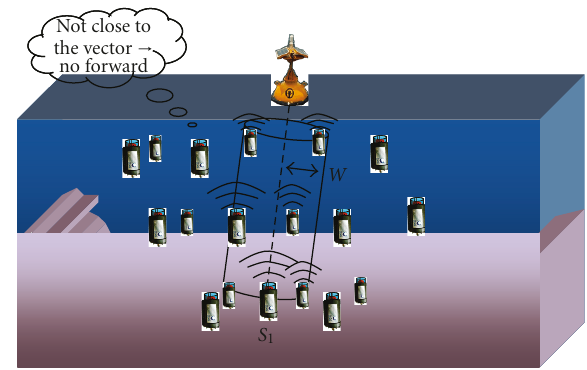
Figure 1: A high-level view of VBF for